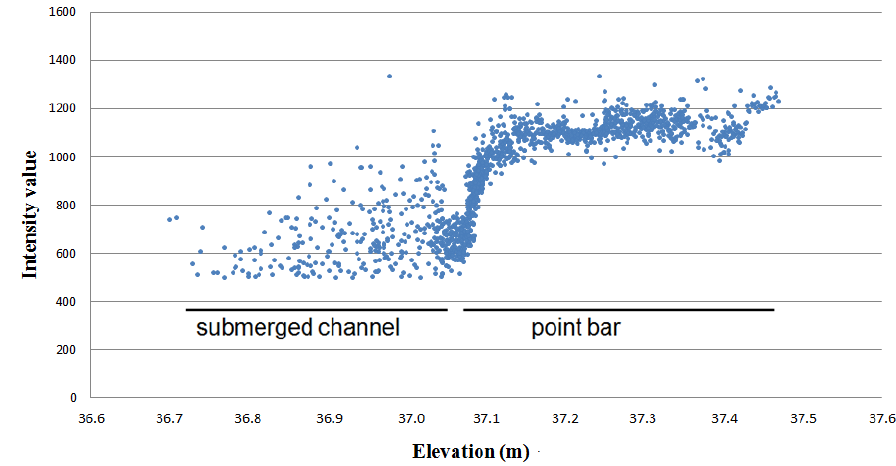
Figure 7. The profile of MLS points on the water–ground boundary indicates that intensity distribution is useful for identifying the shoreline from MLS data. For comparison, the ADCP retrieved water level was approximately 37.05